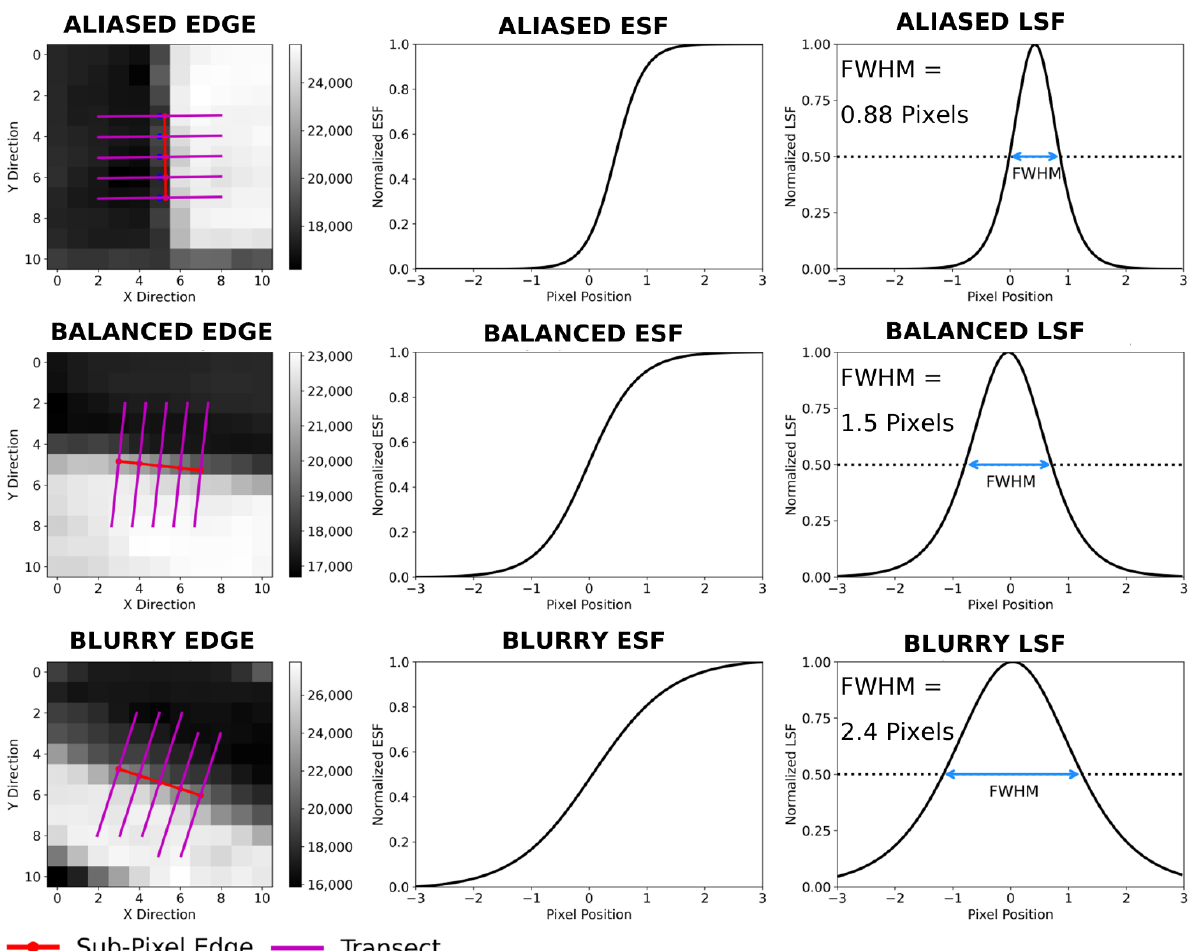
Figure 6. In the figure are displayed, for comparative purposes, examples of aliased (first row), balanced (second row) and blurry (third row) images of edges (expressed in original DN values), normalized ESFs, normalized LSFs, and FWHM values. In the figure are also shown the sub-pixel edges (whose length was fixed to 5 pixels) and the corresponding perpendicular transects. The data were extracted from the L8 image associated with Subset ID #3 (see Table 1).